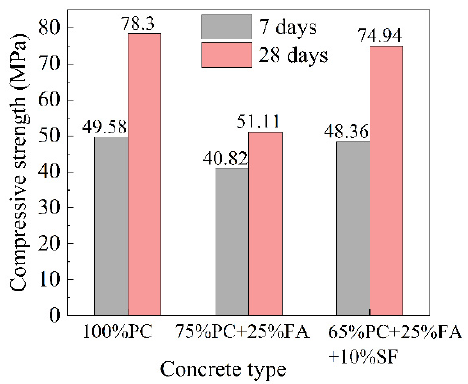
Figure 11. Effect of FA and SF on the compressive strength of SCC